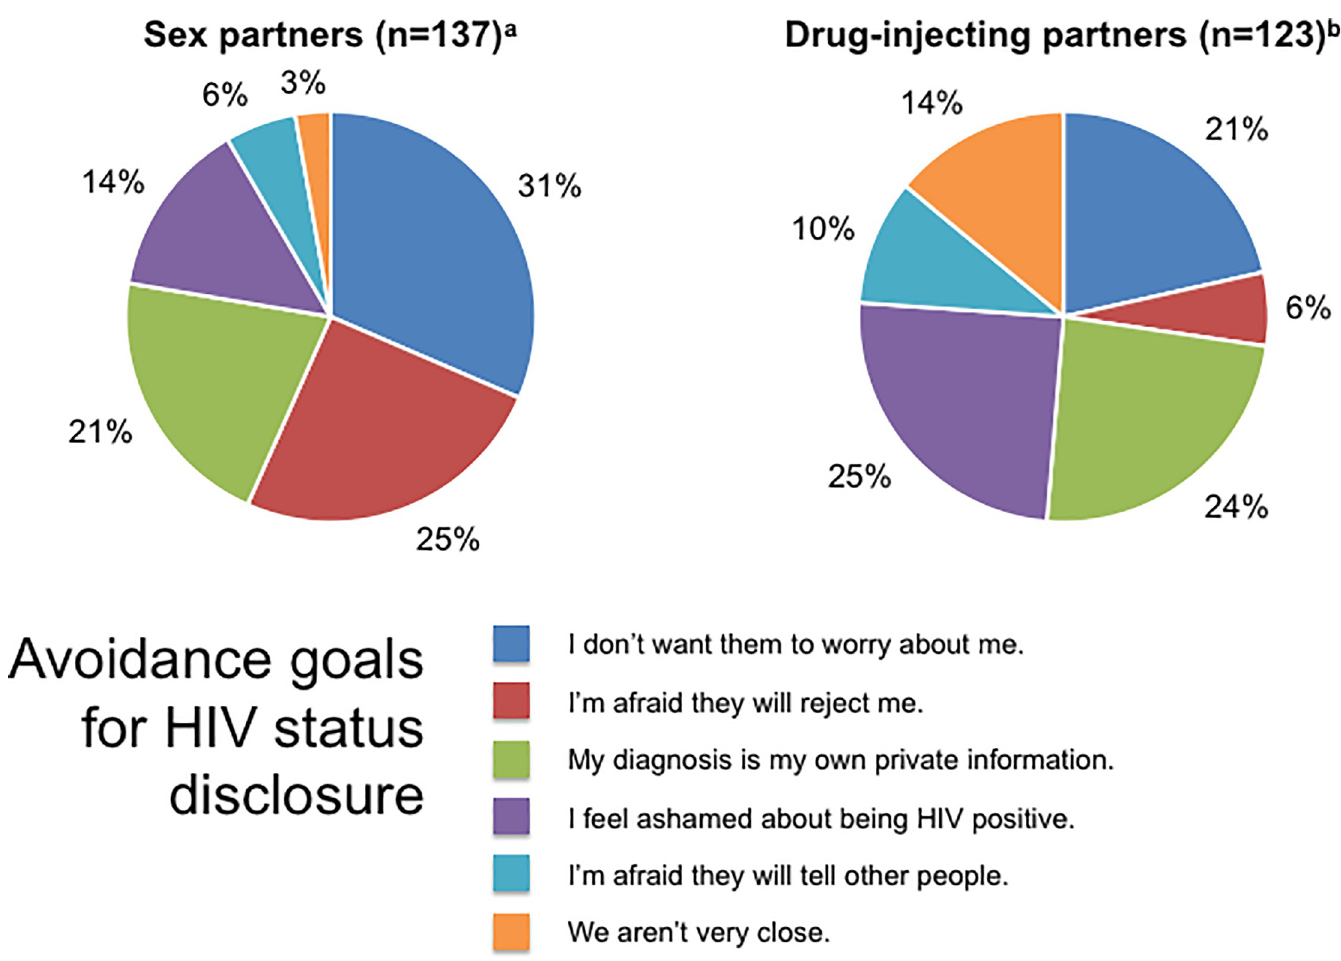
Fig 2. Avoidance goals for HIV status disclosure. a n = number of participants who were sexually active in the 6 months before incarceration. b n = number of participants who injected drugs before